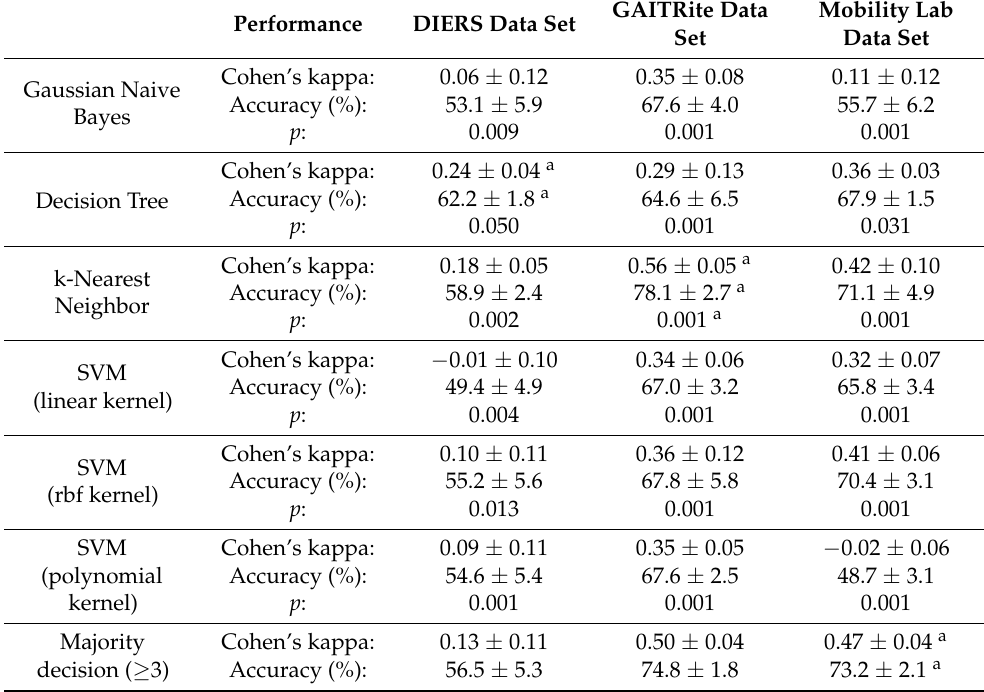
Table 7. Performance of the six classification models on the detection of fatigue in people with multiple sclerosis ( n = 54) after hyperparameter optimization and feature selection. In addition, the majority decision of all six models is shown. A majority decision for a positive label occurs when at least three models ( ≥ 3) predicted the positive class. The values are presented as mean ± stan- dard deviation across 10 times 5-fold cross-validation repetition. a Best overall performance per category for each data set; SVM = Support Vector Machine; rbf = radial basis function; p -value via permutation test. GAITRite Performance DIERS Data Set